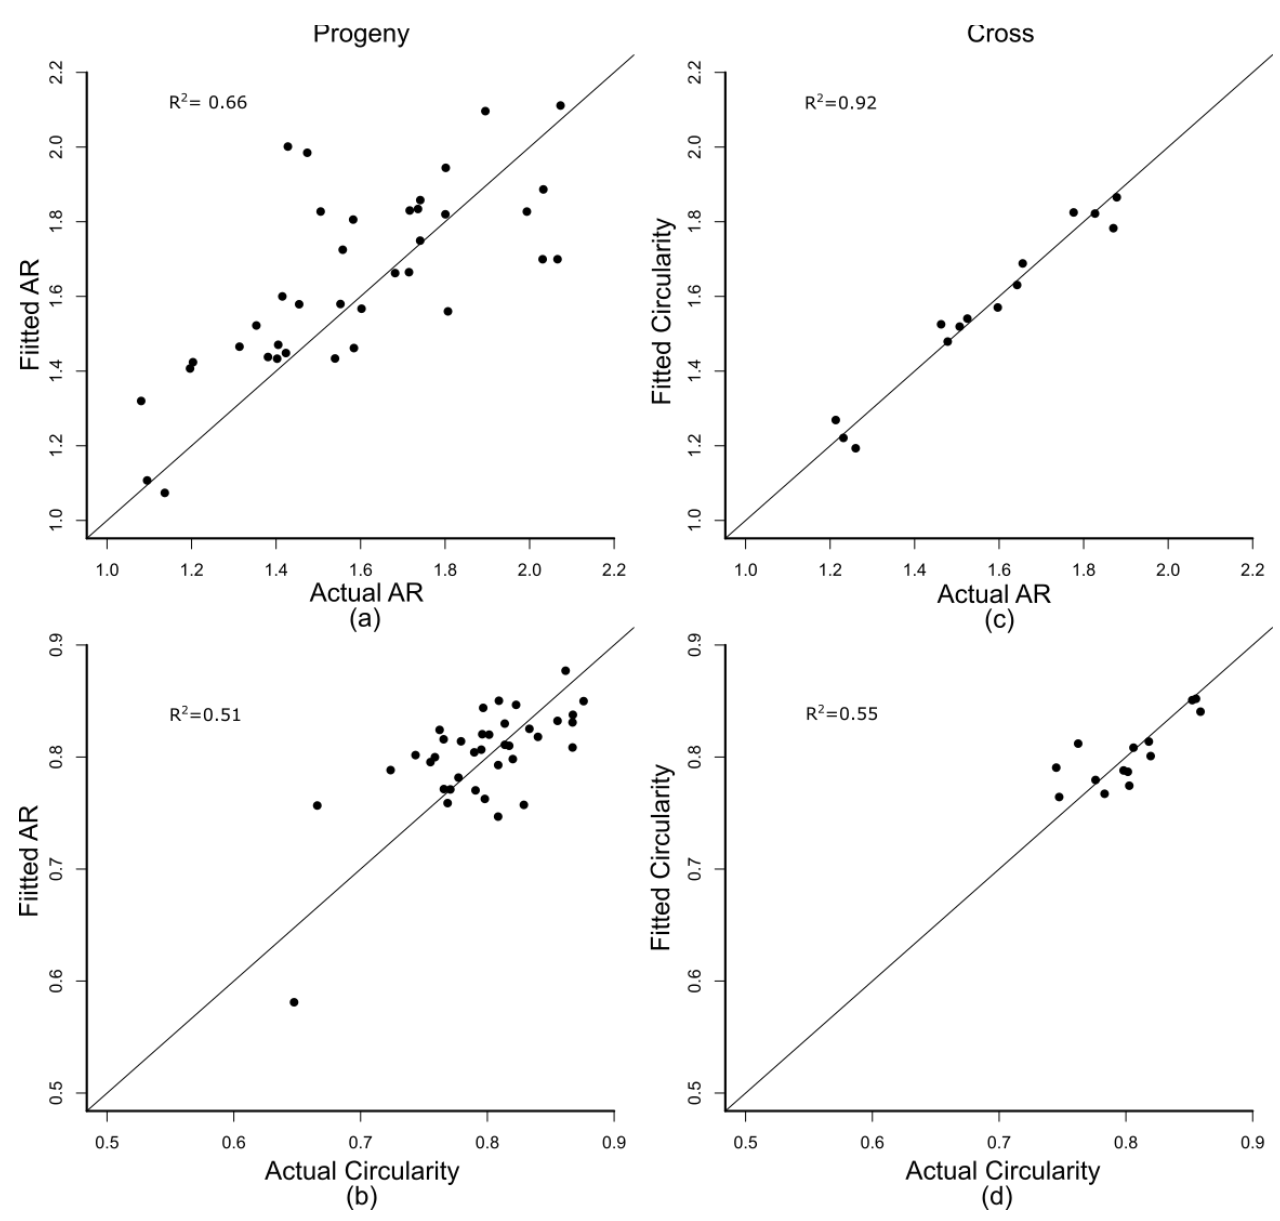
Figure 4. Predicted vs. actual shape values. A prediction model using measurements on greenhouse grown tubers was generated and predicted values were compared to measurements on field grown tubers. ( a ) Predicted progeny AR based vs. actual progeny AR. ( b ) Predicted progeny circularity vs. actual progeny circularity. ( c ) Predicted cross AR vs. actual cross AR. ( d ) Predicted cross circularity vs. actual cross circularity.